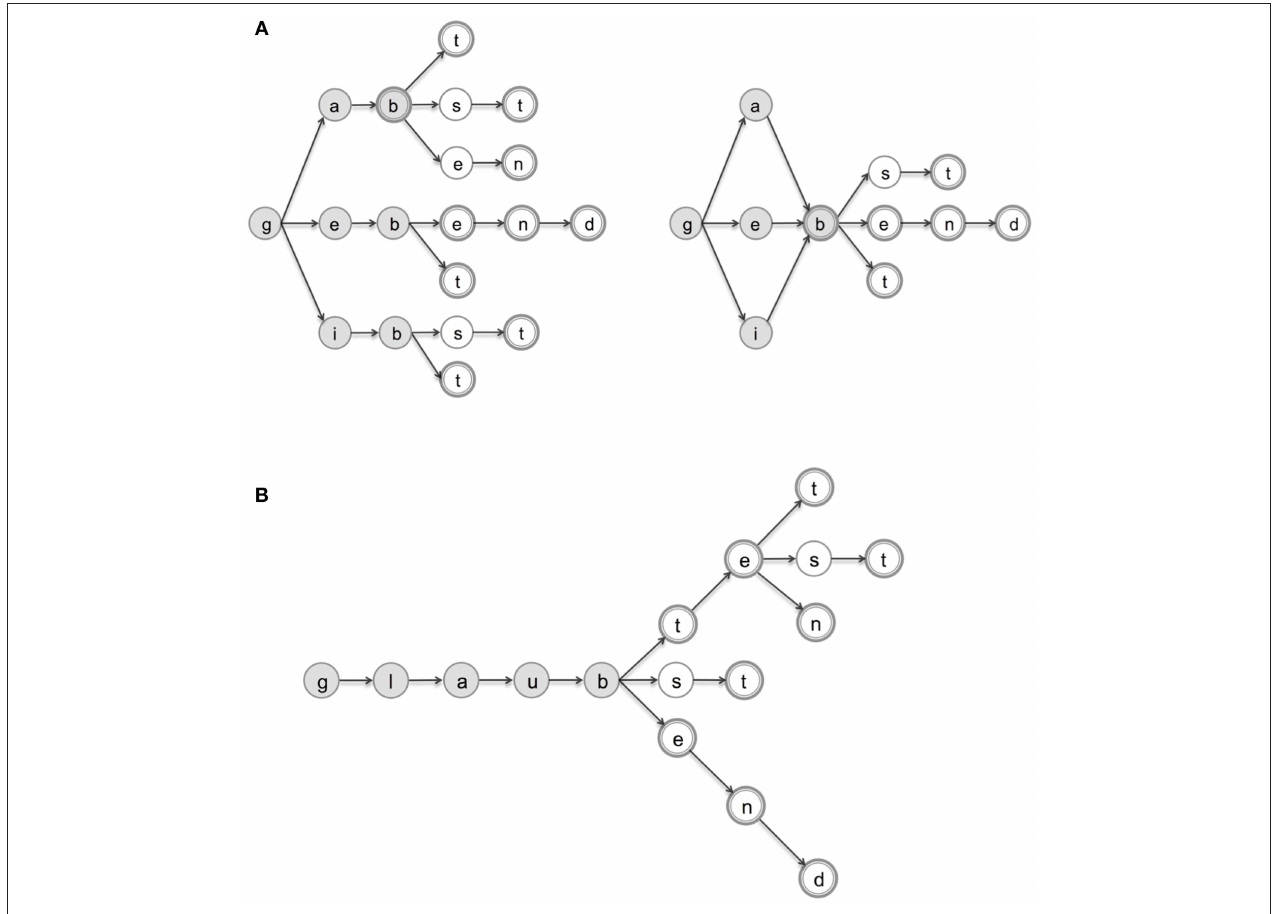
FIGURE 2 | Graph-based representations for a few German verb forms of geben “give” (A) and glauben “believe” (B) . Double-circled nodes represent word-final states, i.e., letters ending a word form; shaded nodes represent (possibly allomorphic) stems, according to the segmentation criteria of section 3.2. In (A) , we provide a word-tree (left) and a word-graph (right) for the same set of 9 form types of geben